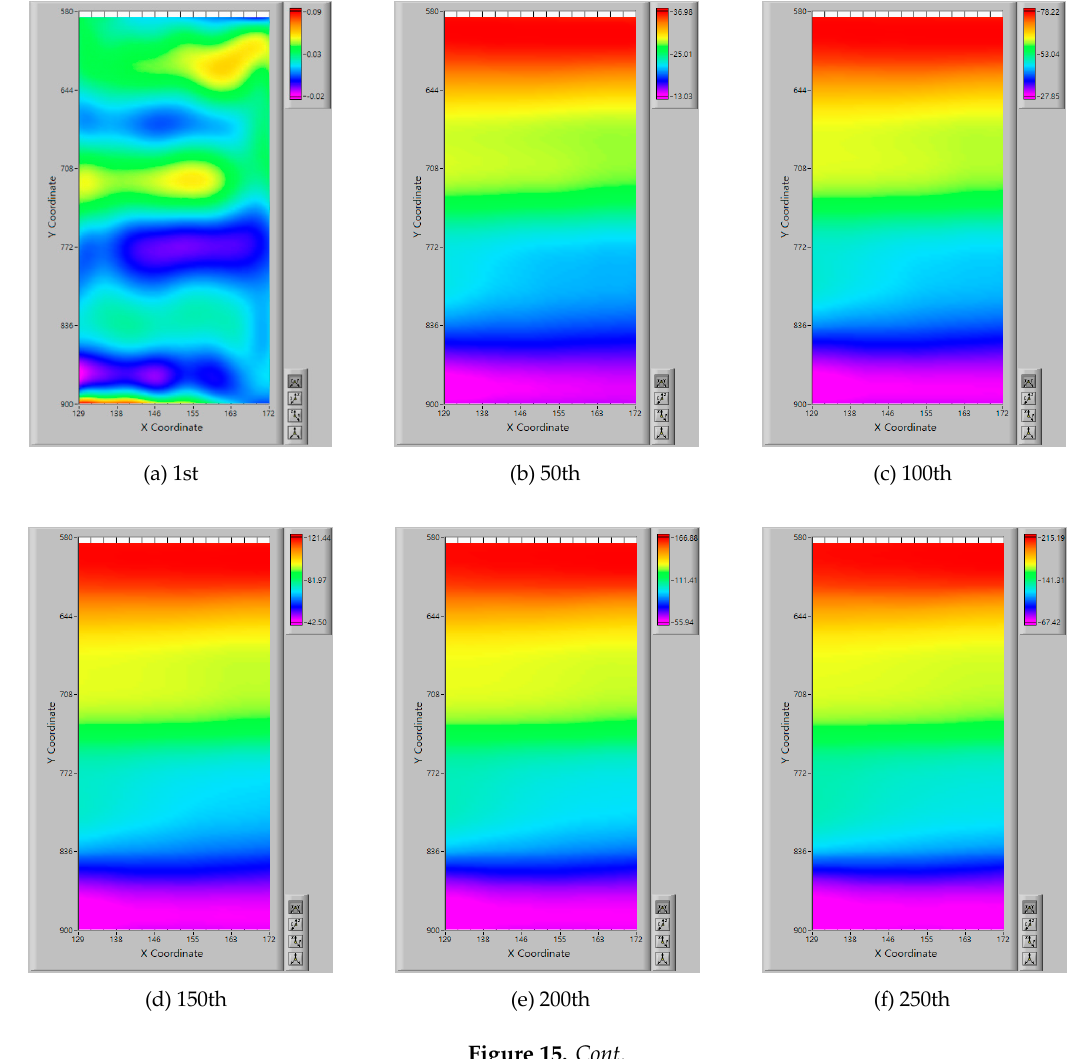
(i) 400th Figure 15. Y direction displacement distributions from DIC measurement.